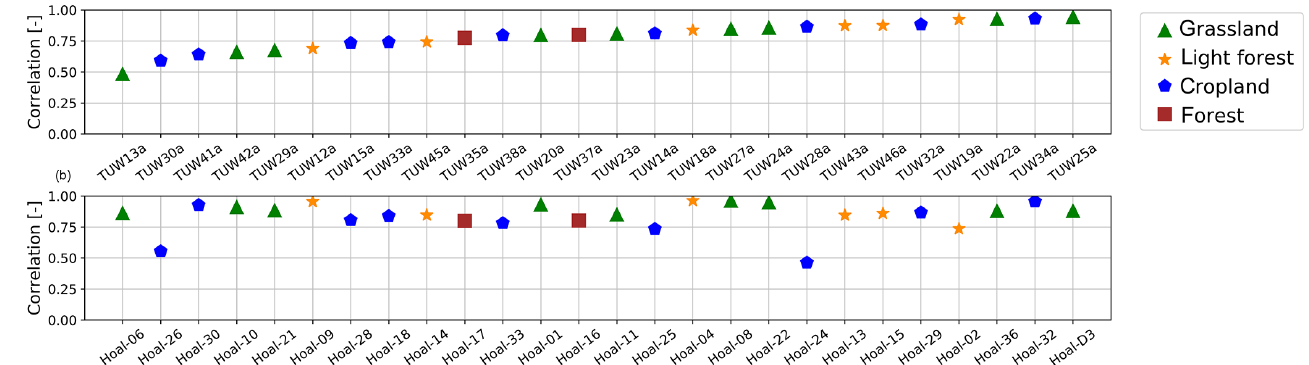
Figure A9. Correlation between the catchment average and individual sensors for (a) FP sensors and (b) corresponding professional probes at a depth of 0.05m, sorted by the correlation value of the FP